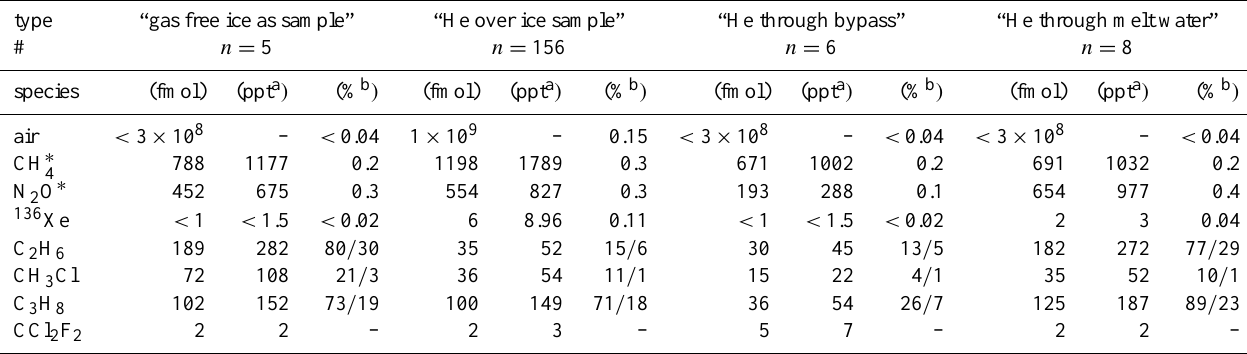
a would be the increase in the sample mixing ratio if the measured amount of species were added to a typical ice sample with an enclosed air volume of 15mL STP (6. 7 × 10 11 fmol). b is the percentage of the blank values relative to the values measured for a typical ice core sample. For C 2 H 6 , CH 3 Cl, and C 3 H 8 , Antarctic values are typically much lower than Greenland values. Therefore, the first values refer to the median of the Antarctic TALDICE samples, and the second values to the Greenland NGRIP samples (see Tables 4 and 5). For the other parameters, only the relation to Antarctica is shown.